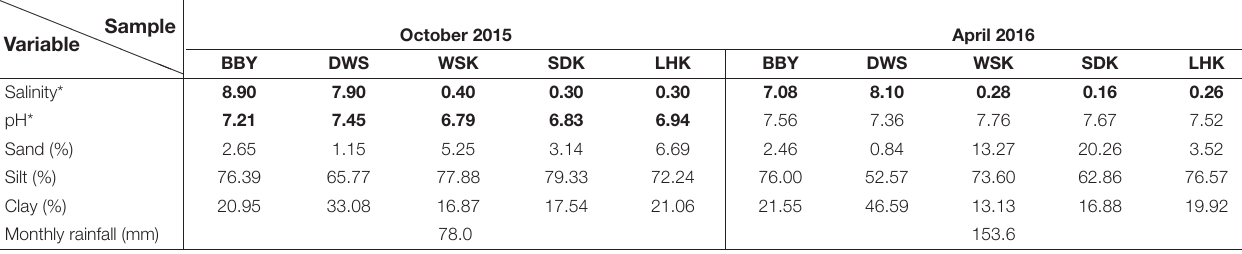
TABLE 1 | Summary of environmental variables of salt marsh and estuarine mudflat sediment samples. (cid:97) (cid:97) (cid:97) (cid:97) (cid:97)